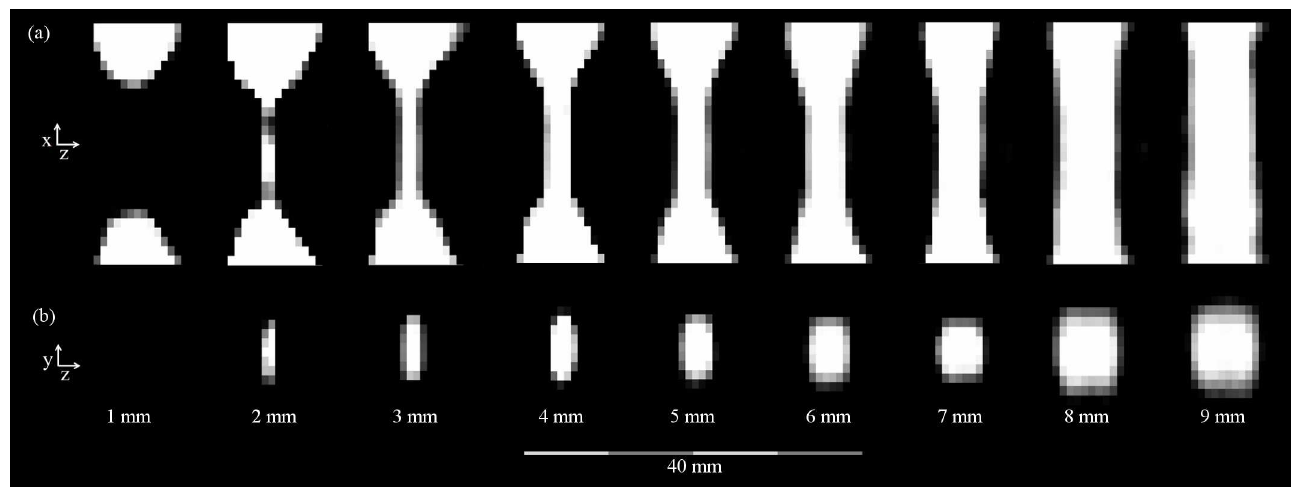
Fig 4. MPI-Images of the stenosis phantoms. Sagittal (a) and axial (b) slices extracted from reconstructed 3D image data of the stenosis phantoms. The lumen of the 1 mm stenosisis not discernible. Note the anisotropyof the axial images due to the different gradientfield strengths, leadingto an oval appearance of the phantomswhich is the more pronounced, the smaller the lumen is.